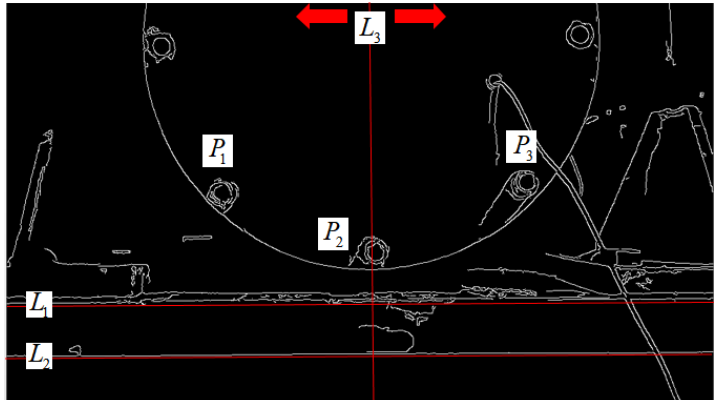
Figure 12. Effect of canny edge detection.